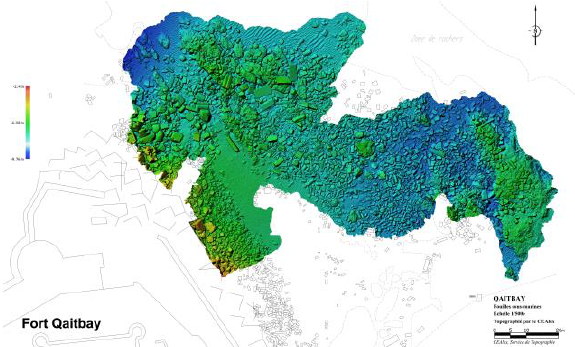
Figure 15. Orthophoto (50152 images) of 7200 m 2 from 2014 until 2016 (photography by Mohamed Elsayed, processing by